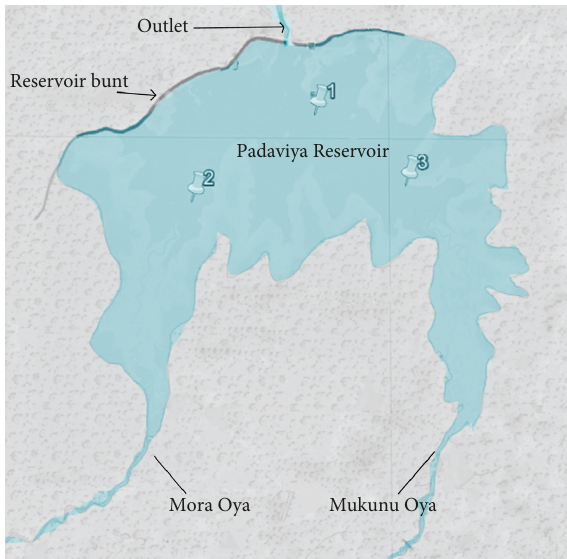
Figure 2: Sampling locations at the Padaviya Reservoir. Main sampling stations monitored in the study are shown as 1, 2, and